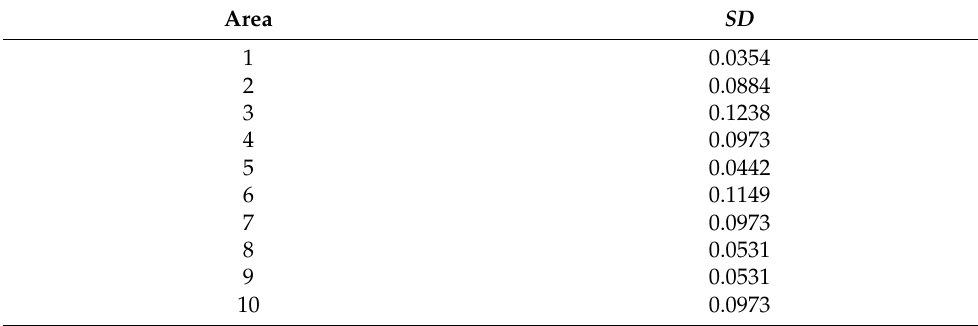
Table 8. Pearson correlation analysis between C sp and SD for the ten studied water areas. p -Value Correlation Coefficient <0.05 0.705 Unit of SD: pcs / (cid:0) s × nmile 2